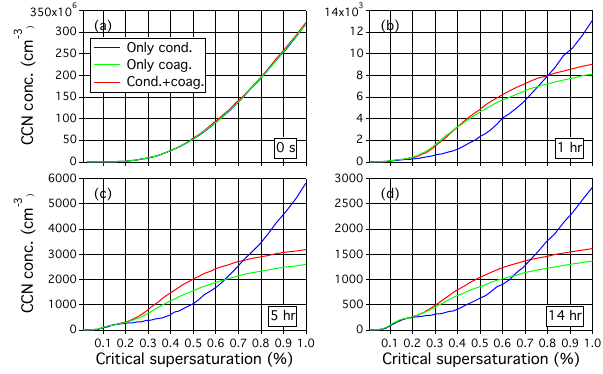
Figure 9. CCN number concentrations as the function of critical supersaturation at 0s, 1h, 5h and 14h for the base